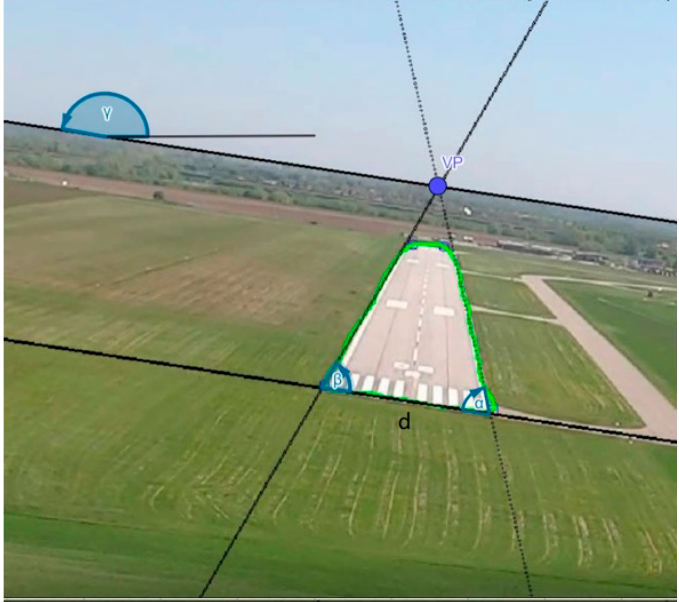
Figure 2. The detected lines were matched using the RANSAC algorithm.